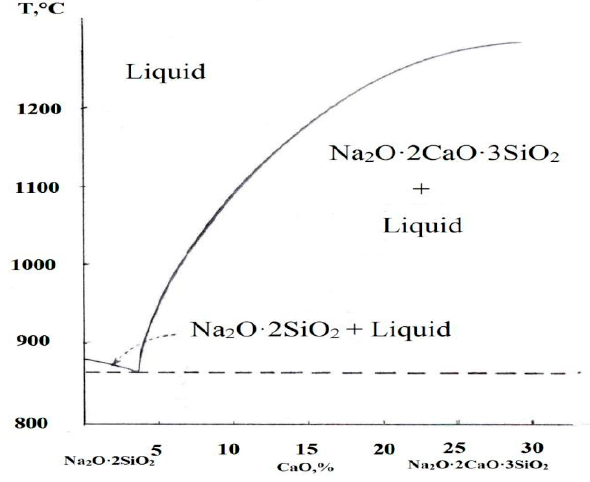
Figure 7. Diagram of system Na 2 O·2SiO 2 –Na 2 O·2CaO·3SiO 2 .